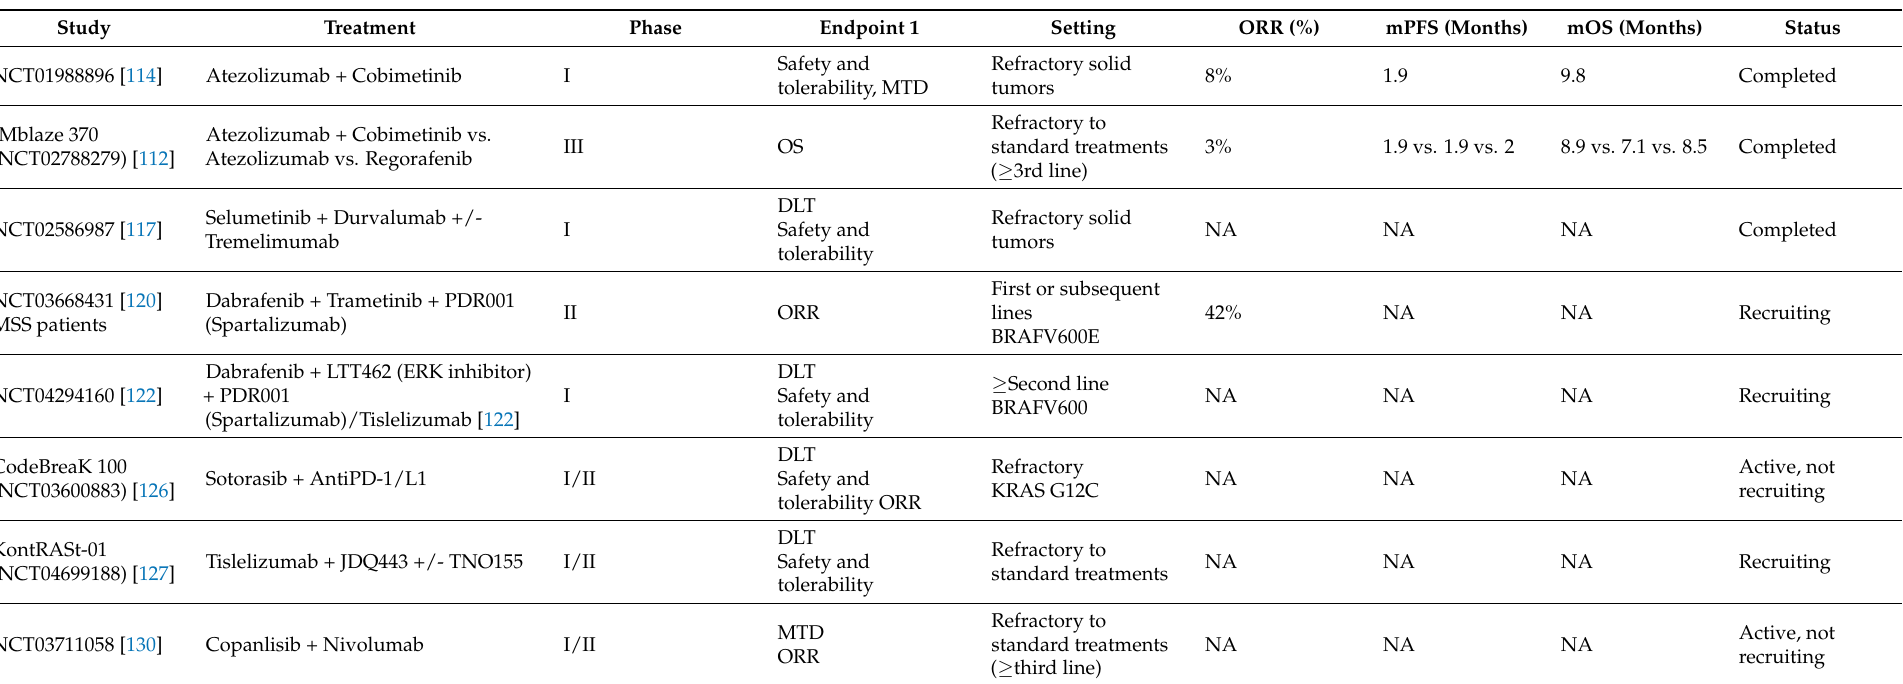
Table 7. Currently ongoing and completed clinical trials of inhibitors of MAPK/PIK3CA and ICIs in MSS